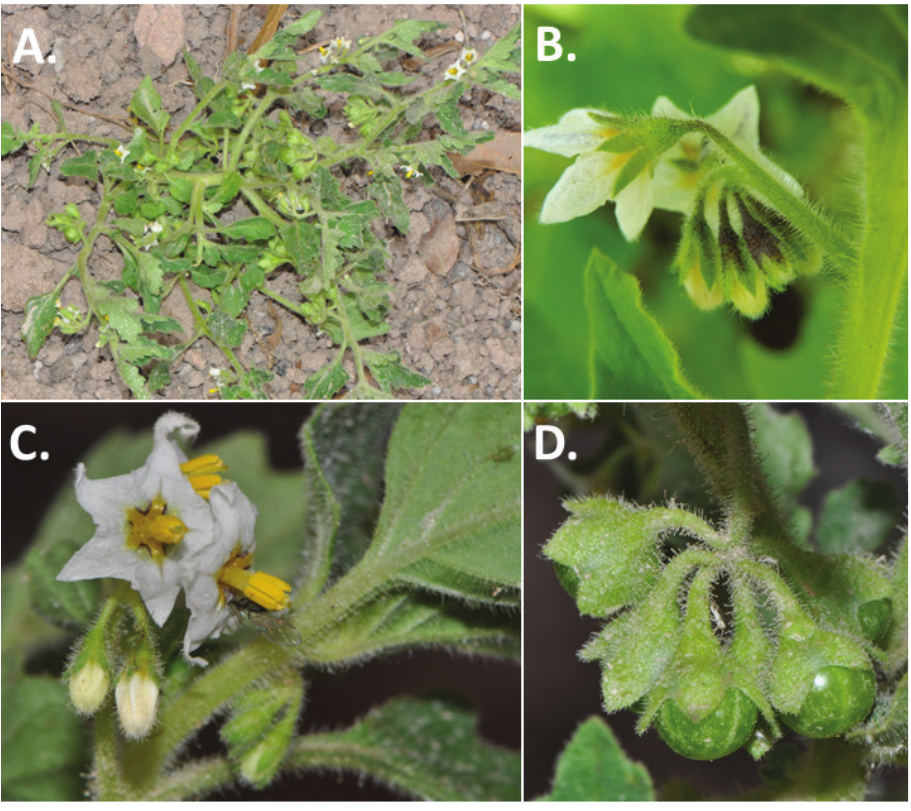
Figure 34. Solanum nitidibaccatum Bitter. A Habit B young inflorescence with flower buds C flowers at anthesis D maturing fruits ( A–D Särkinen et al. 4076 ). Photos by T. Särkinen (previously published in “PhytoKeys